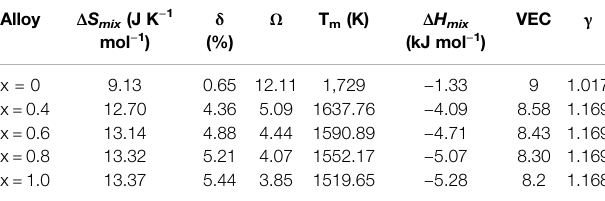
TABLE 6 | Relevant parameters of FeCoNi(CuAl) x MEA and HEAs.